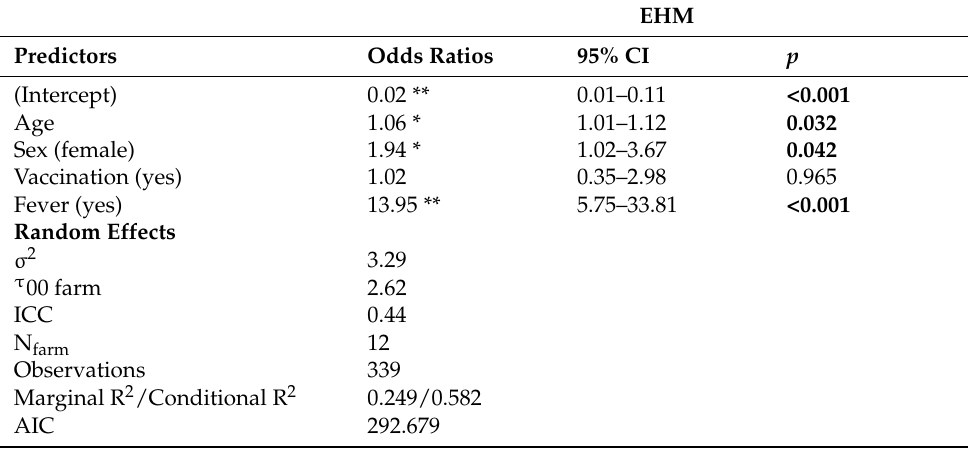
Table 3. Results of the logistic mixed